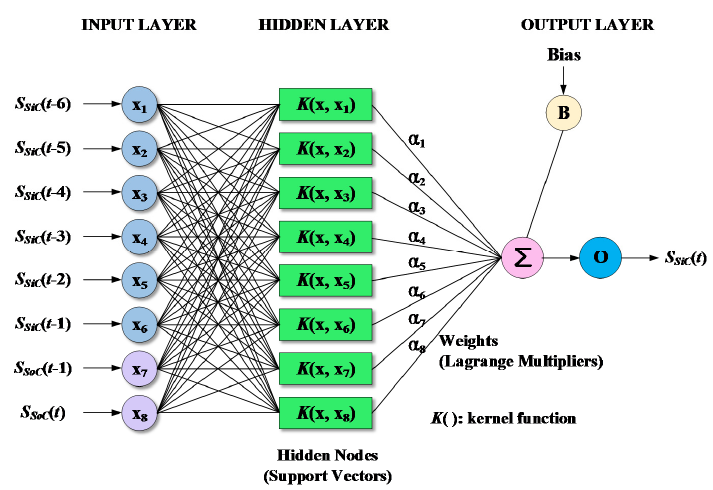
Figure 5. An example of SVM model architecture.